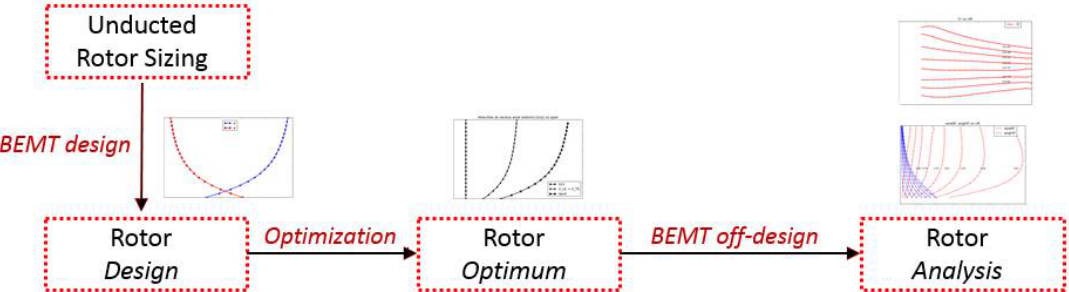
Figure 1. Propeller design steps in the tool py_BEM at on-design and off-design points.